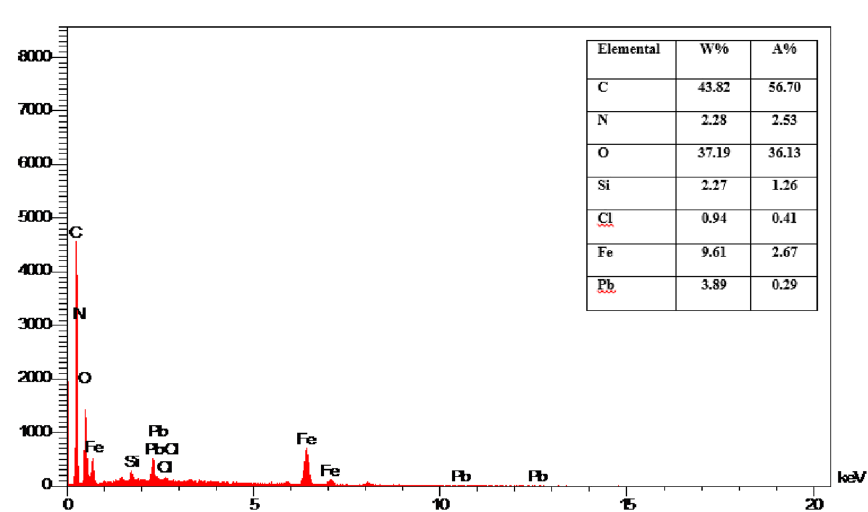
Figure 10. EDAX analysis of Pb 2+ adsorbed Pip@MGO